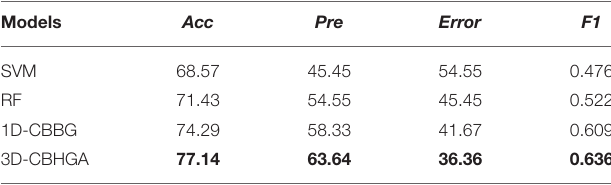
TABLE 4 | Performance of different models on